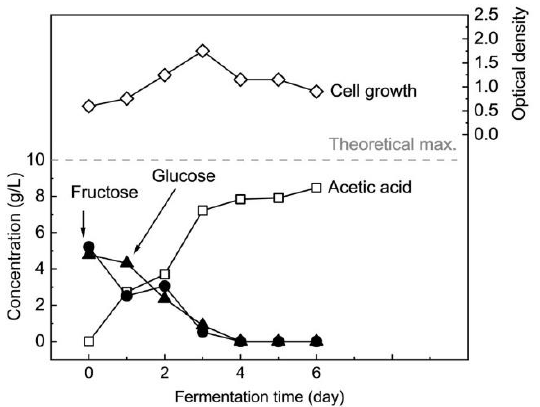
Figure 1. Batch fermentation profile of 10.0 g/L of sugars in hydrolyzed nipa sap by M. thermoacetica with full nutrient .